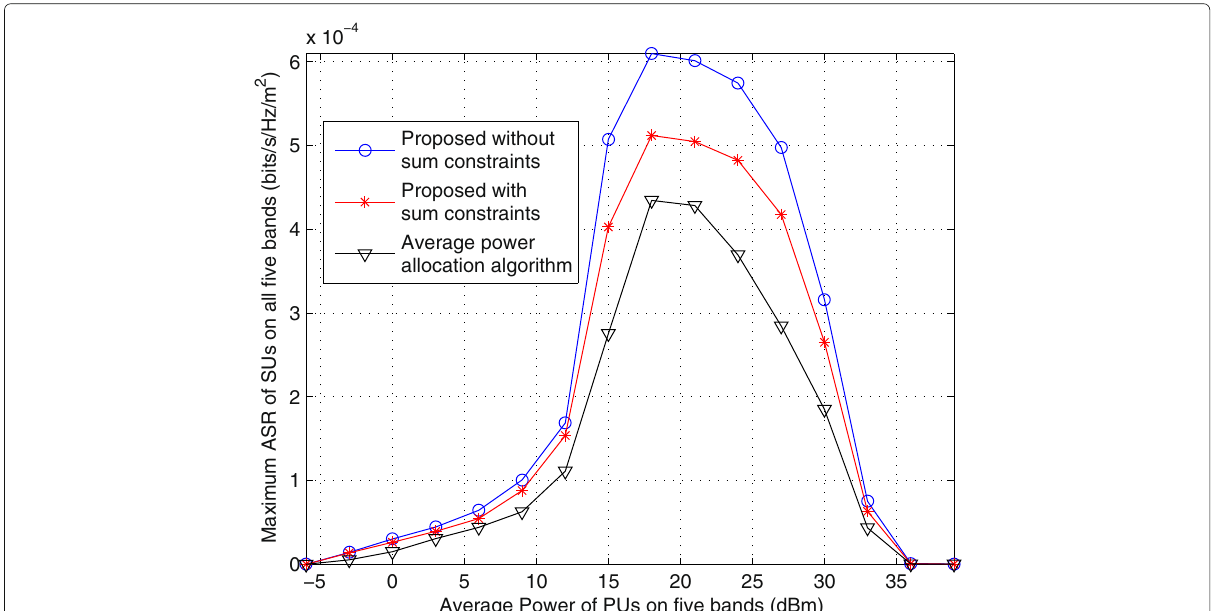
Fig. 9 Maximum ASR of SUs vs. average power of PUs on all five